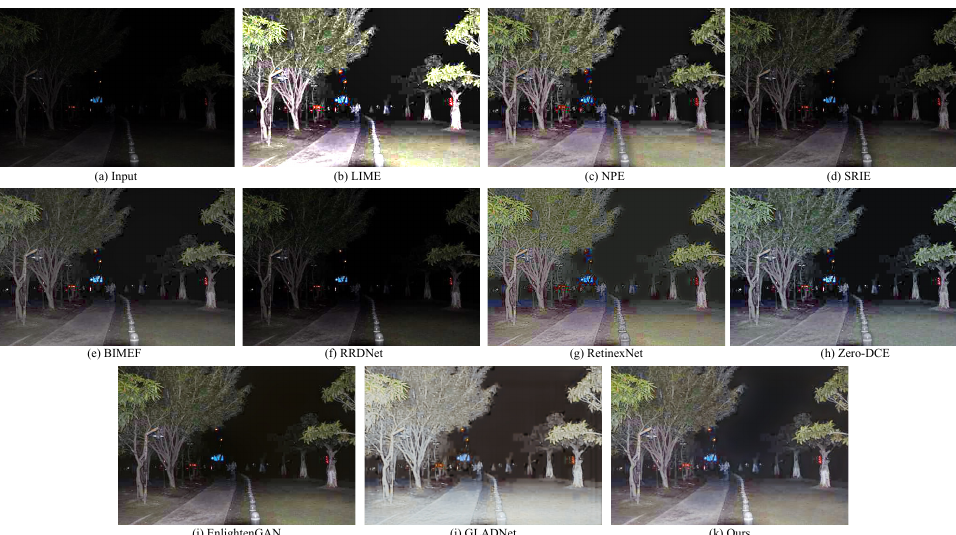
Figure 10. Visual comparisons of different methods on a real image from MFUSION dataset.